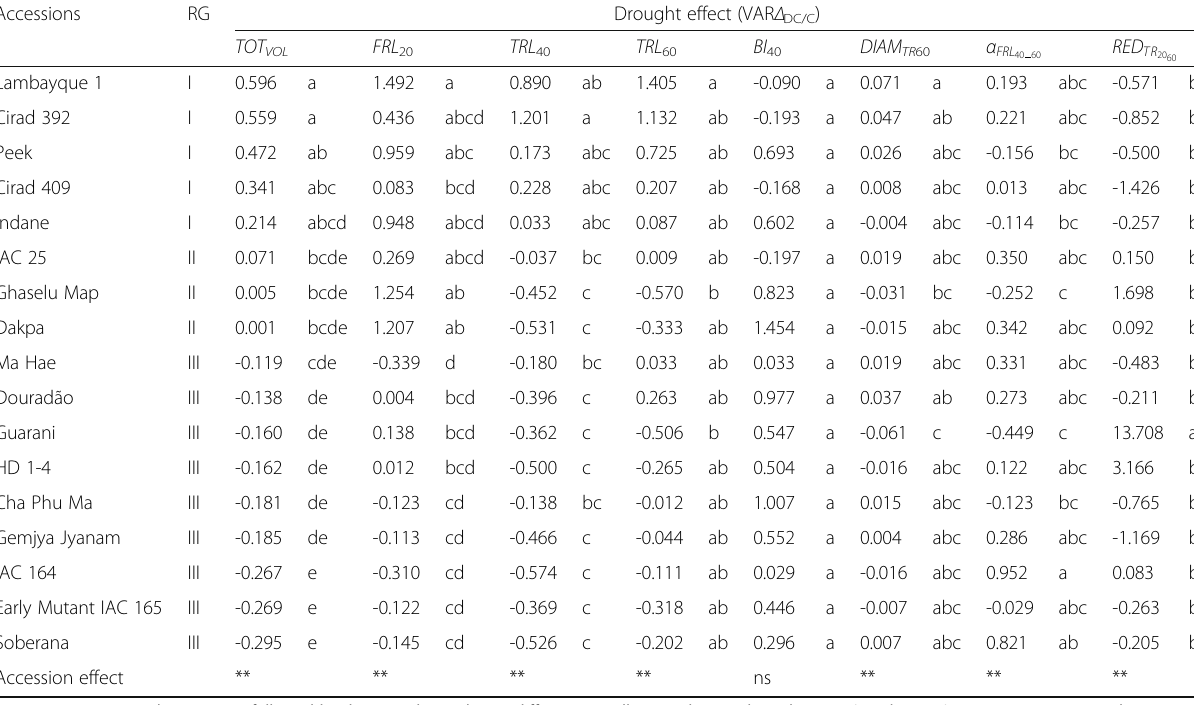
Table 5 Relative variation of the selected root traits from irrigated to water deficit conditions Accessions RG Drought effect (VAR Δ DC/C